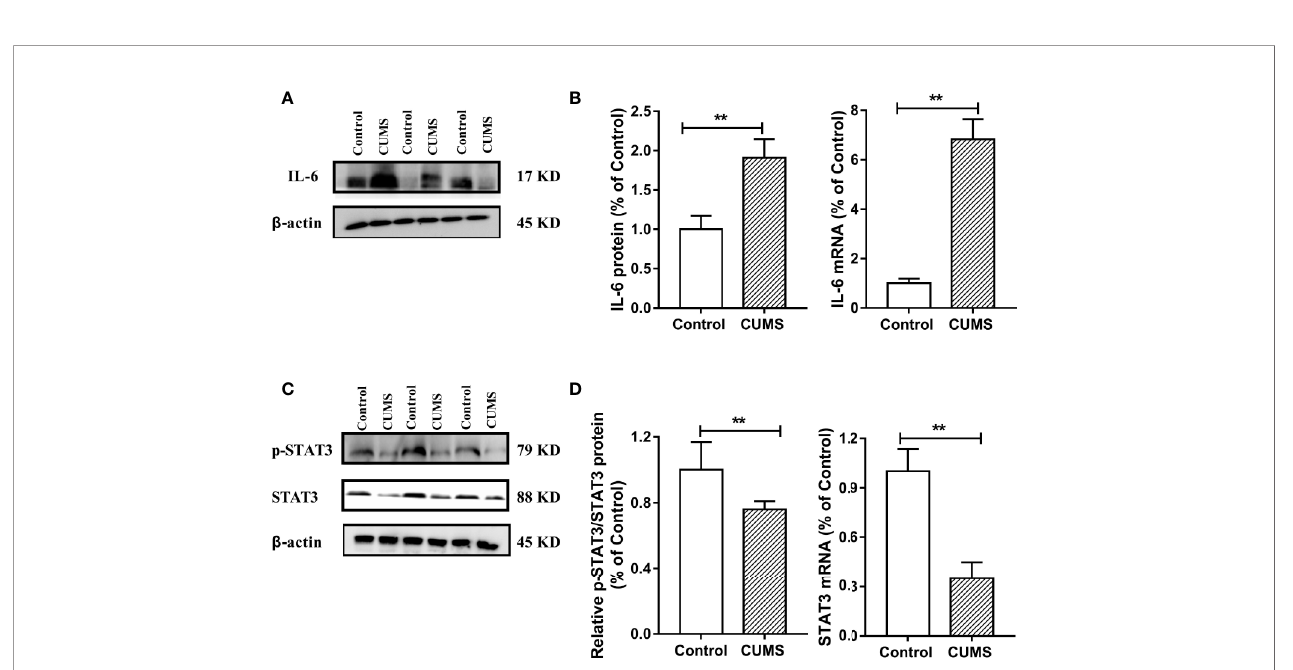
FIGURE 7 | Effect of CUMS exposure on IL-6-mediated STAT3 signaling in the hypothalamus of rats. (A) The IL-6 protein representative images for immunoblots. (B) Protein and mRNA levels of IL-6. (C) The p-STAT3 and STAT3 protein representative images for immunoblots. (D) Relative p-STAT3/STAT3 protein and mRNA levels of STAT3. Data are presented as mean ± SD, n = 6; **p < 0.01 vs. Control